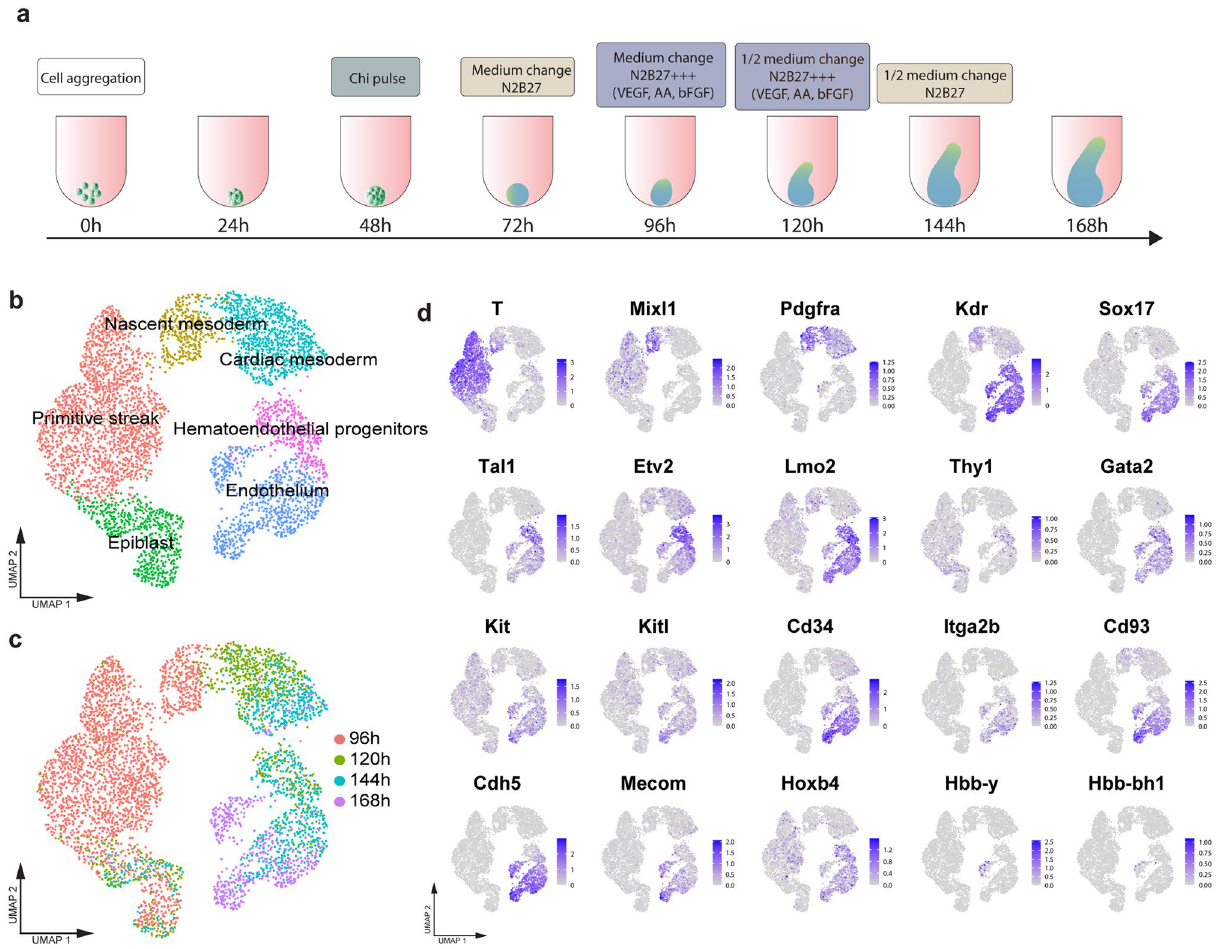
Figure 1. Gastruloids express markers of early blood development. ( a ) Experimental outline of the protocol used for gastruloid generation. ( b–c ) UMAP plots showing ( b ) clusters on the trajectories from epiblast to endothelium and ( c ) the distribution of cells in the UMAP plots according to analyzed time points. ( d ) UMAP plots showing the expression of hematopoiesis-related genes in the scRNA-seq dataset. n= 2 replicates per time point. Dataset from 9